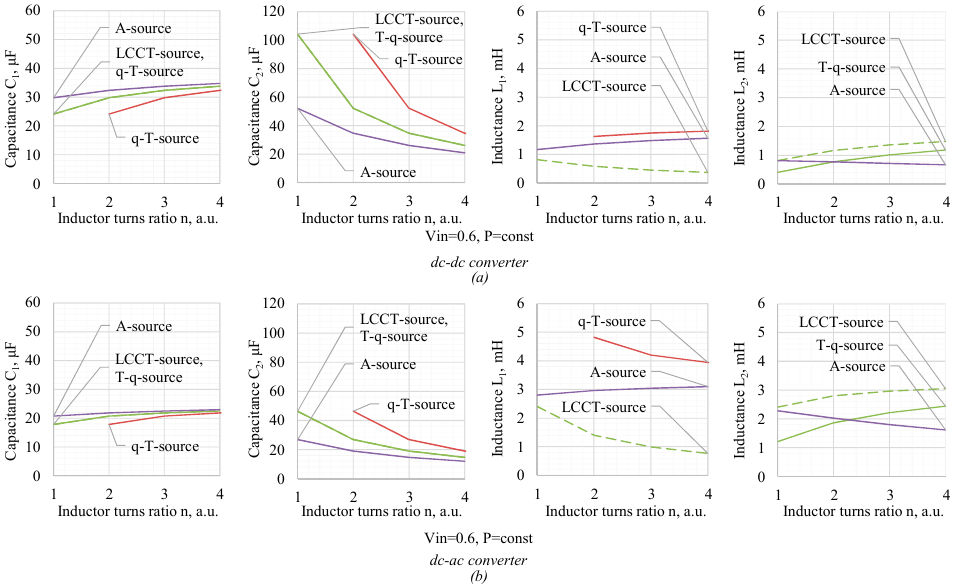
Figure 5. Value of the passive components as a function of the different value of turns ratio ( n ) for ( a ) the dc-dc converter and ( b ) the inverter, with V in = 0.6. Figure 7 shows the dependence of conduction losses versus the input voltage. It is based on the assumption that conduction losses are proportional to the RMS current value in transistors and the average current in diodes. The same type of transistors and diodes were selected for all topologies ( V F = 0.8, R DS = 0.27). It can be seen that despite a constant value of the input current, the high power losses correspond to the high boost. It means that the ST current is increasing and leads to the conduction losses increasing in semiconductors. It can also be seen that the value of the turns ratio leads to the conduction losses increasing as well. It is explained by the current ripple increasing in the semiconductors.